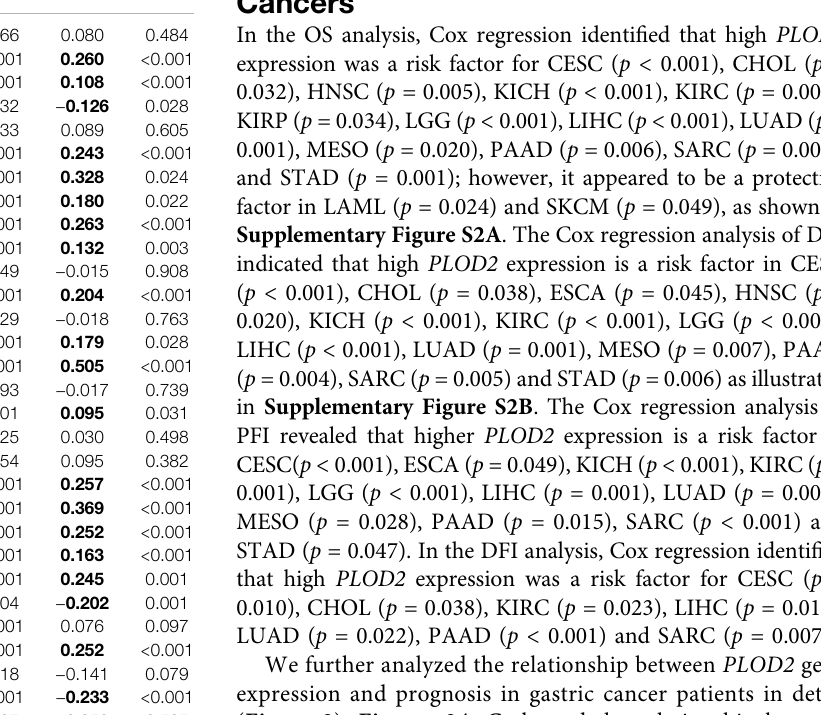
Supplementary Figure S2A . The Cox regression analysis of DSS